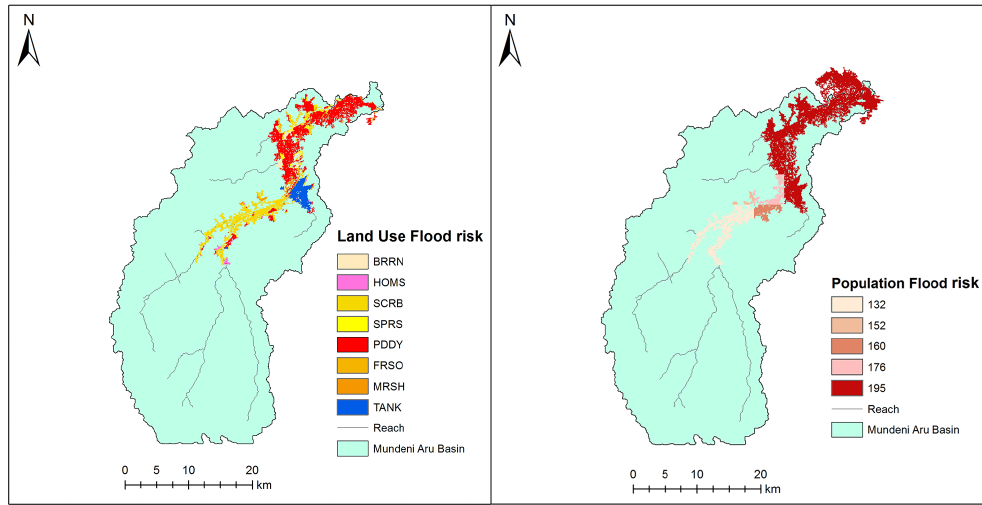
Figure 6. Flood-risk analysis: Land use (left) and population density (right) under the risk of flooding.